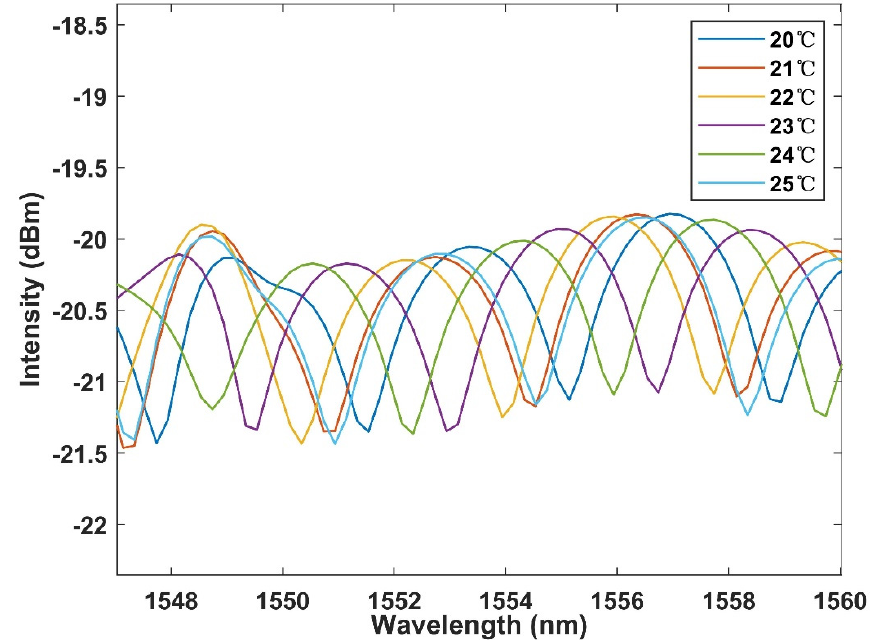
Figure 6. Spectral output characteristics of single Sagnac ring structure with temperature change.